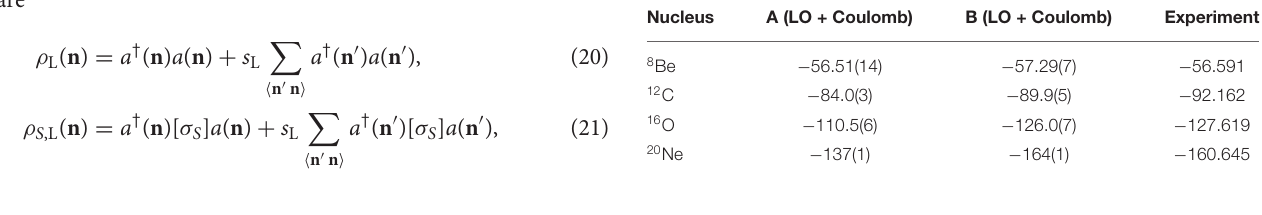
TABLE 1 | Results for the ground energies of 8 Be, 12 C, 16 O, and 20 Ne using interactions A and B at LO with Coulomb interactions and the comparison with experimental